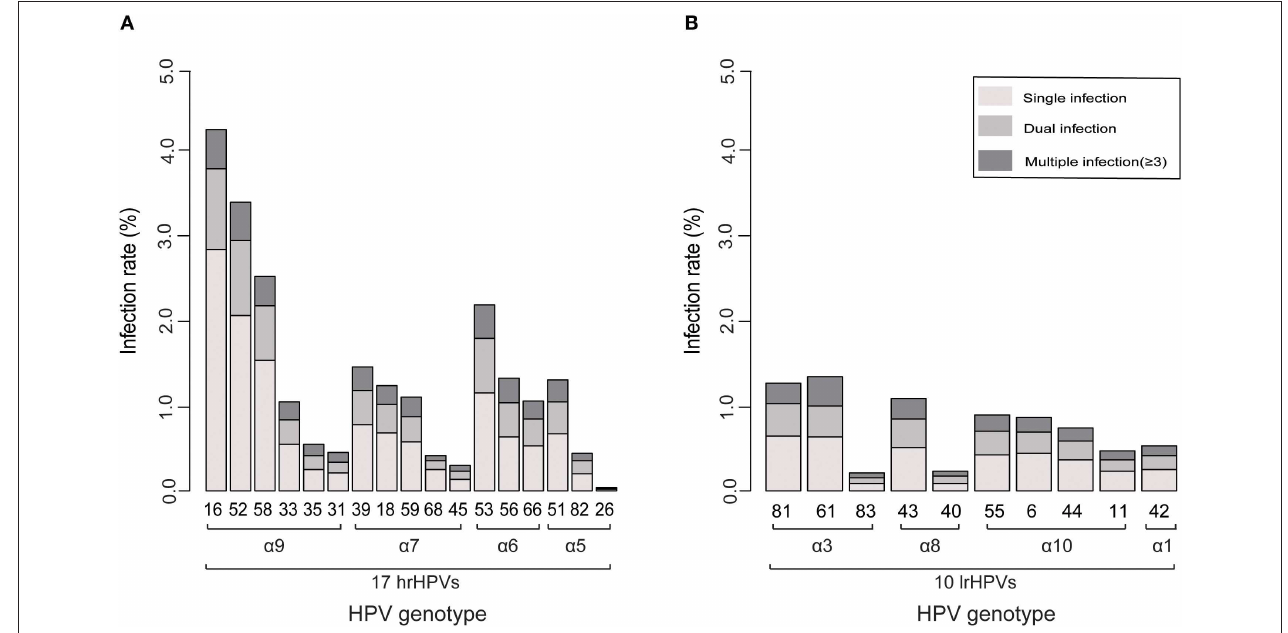
FIGURE 2 | Ranking of the prevalence of each genotype related to its phylogenetic group. (A) 17 hrHPVs. (B) 10 lrHPVs.